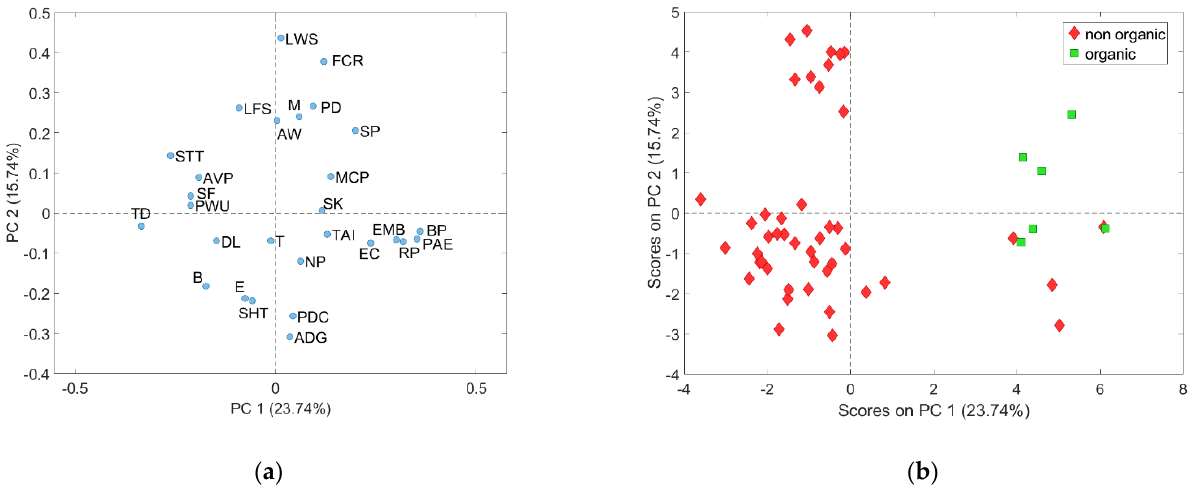
Figure 1. ( a ) Loading plot of PC1 and PC2; ( b ) Score plot of PC1 and PC2, representing organic and non-organic farms.